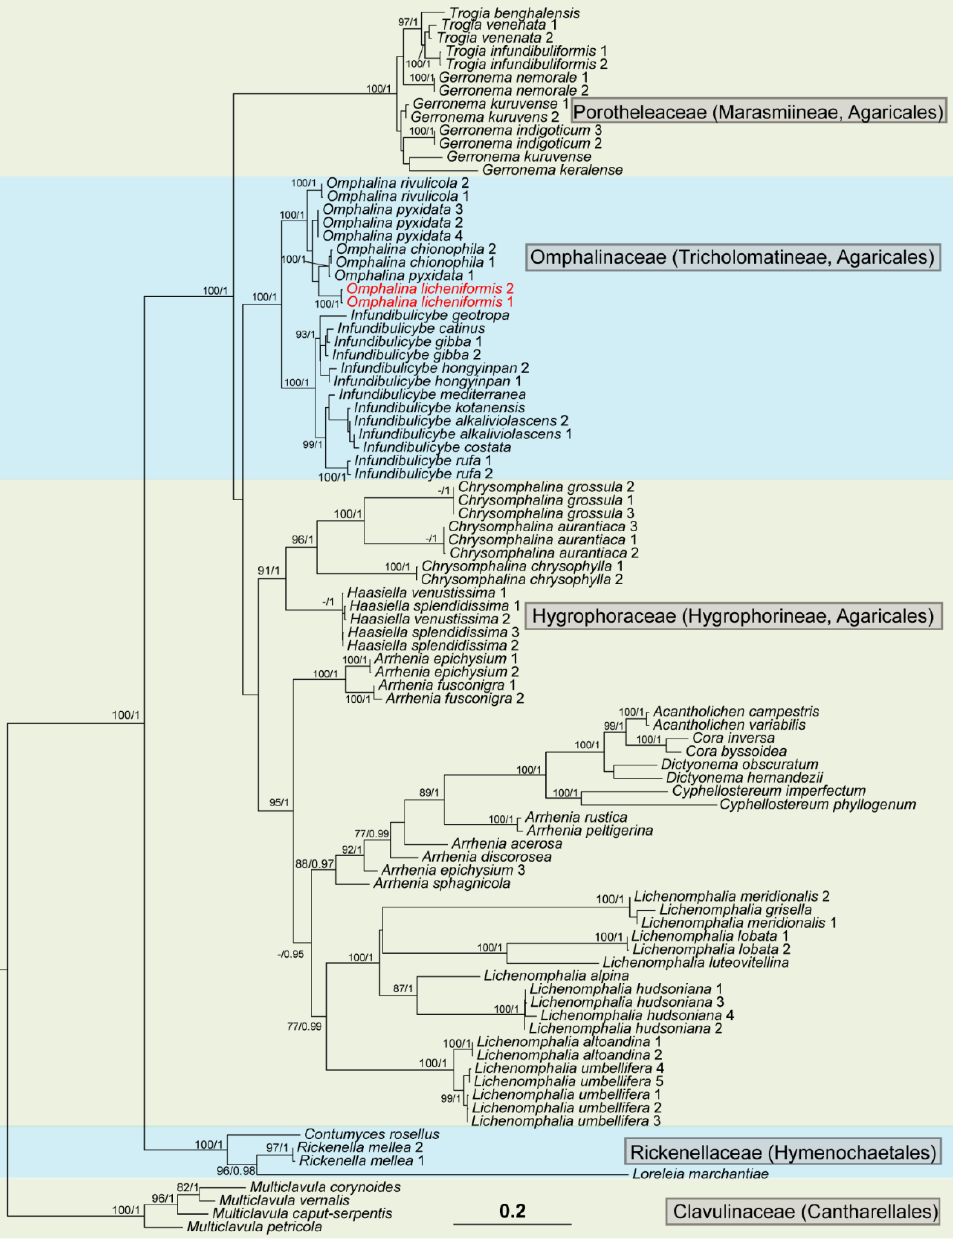
Figure 2. The RAxML tree of omphalinoid species based on the concatenated ITS + nuLSU dataset. The numbers in each node represent bootstrap support (BS) and posterior probability (PP) values. BS values ≥ 75% and PP values ≥ 0.95 were plotted on the branches of the tree. The samples corresponding to the new species are in red. Scale in 0.2 substitution per site.